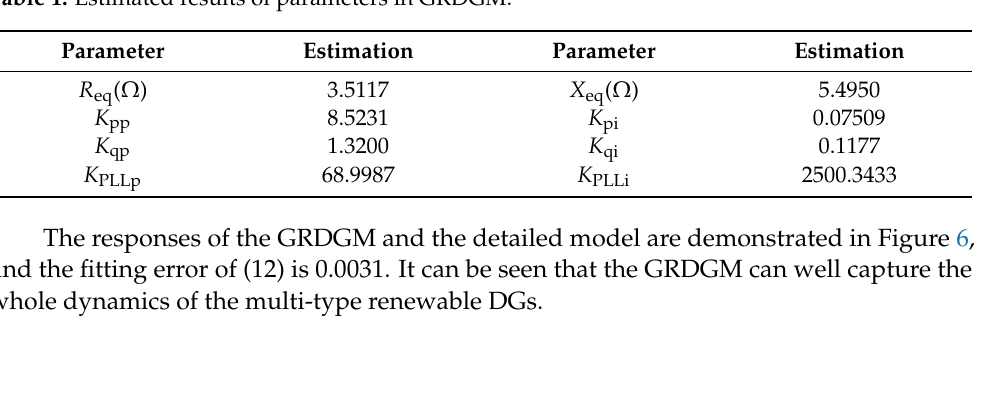
Table 1. Estimated results of parameters in